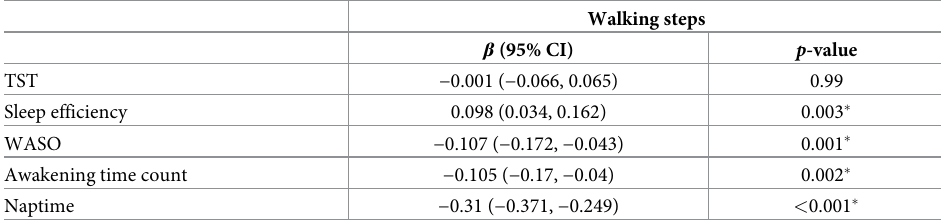
Table 1. Multiple regression model showing the association between the daily walking steps and sleep parameters.